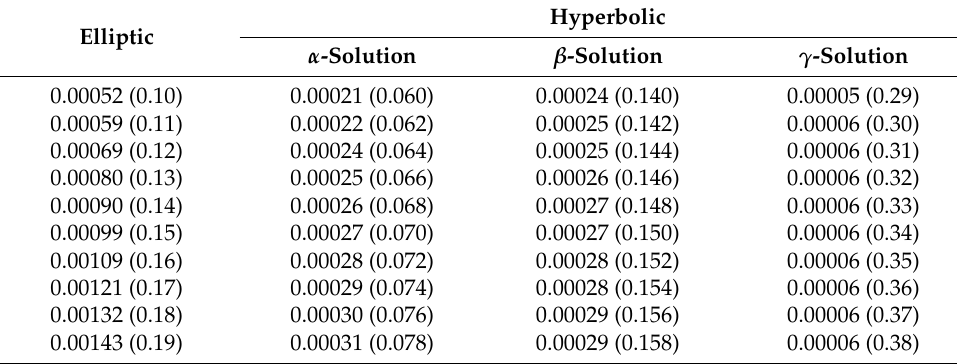
√ Table 2. The MSE of local regression method with l = 1 and bandwidth h (presented in parenthesis) in estimating the critical collapse response function g ( z ) = | f 0 ( z ) | in elliptic and hyperbolic cases based on a training sample of size n = 100.